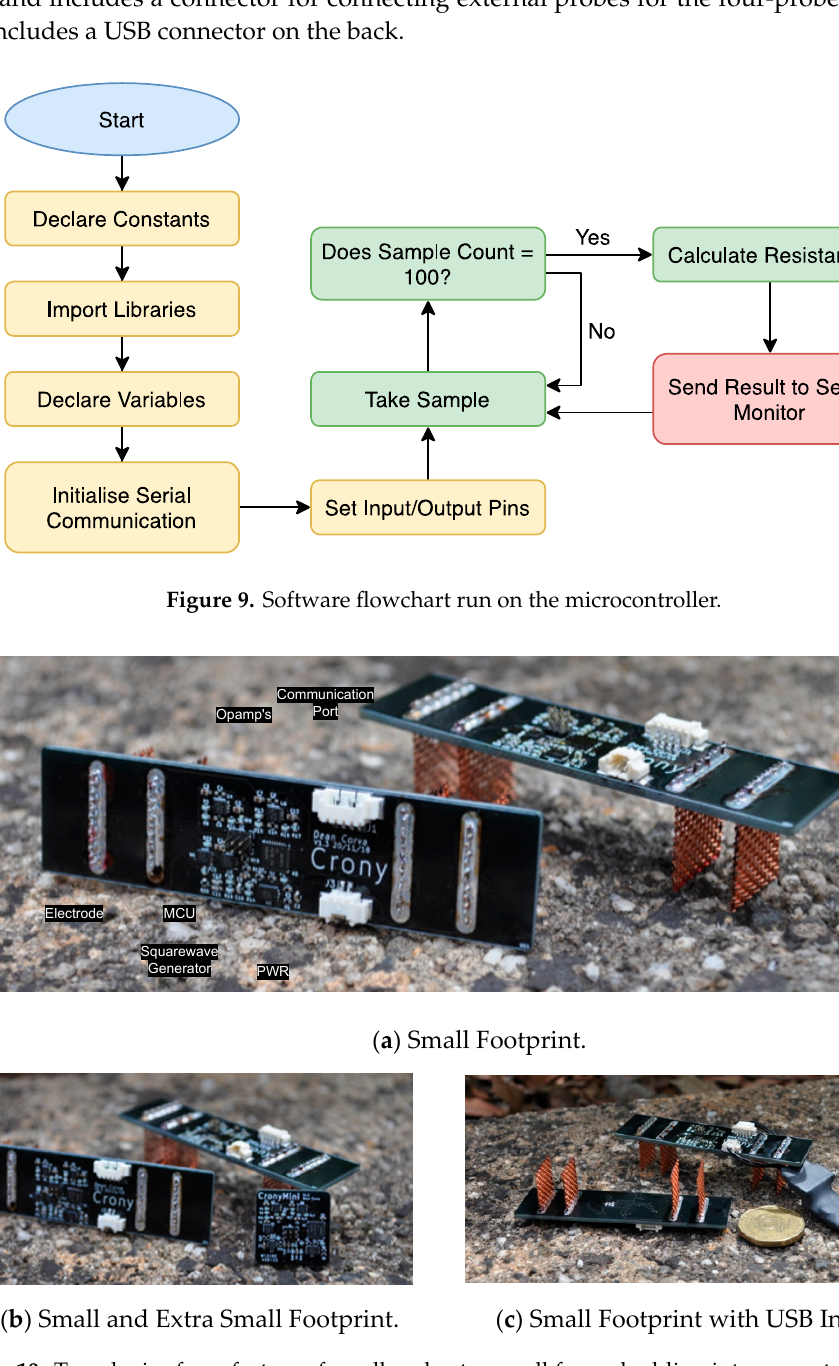
Figure 10. Two device form factors of small and extra small for embedding into concrete: ( a ) small revision dimensions are 20 mm × 20 mm × 80 mm; ( b ) extra small revision dimensions are 3 mm × 15